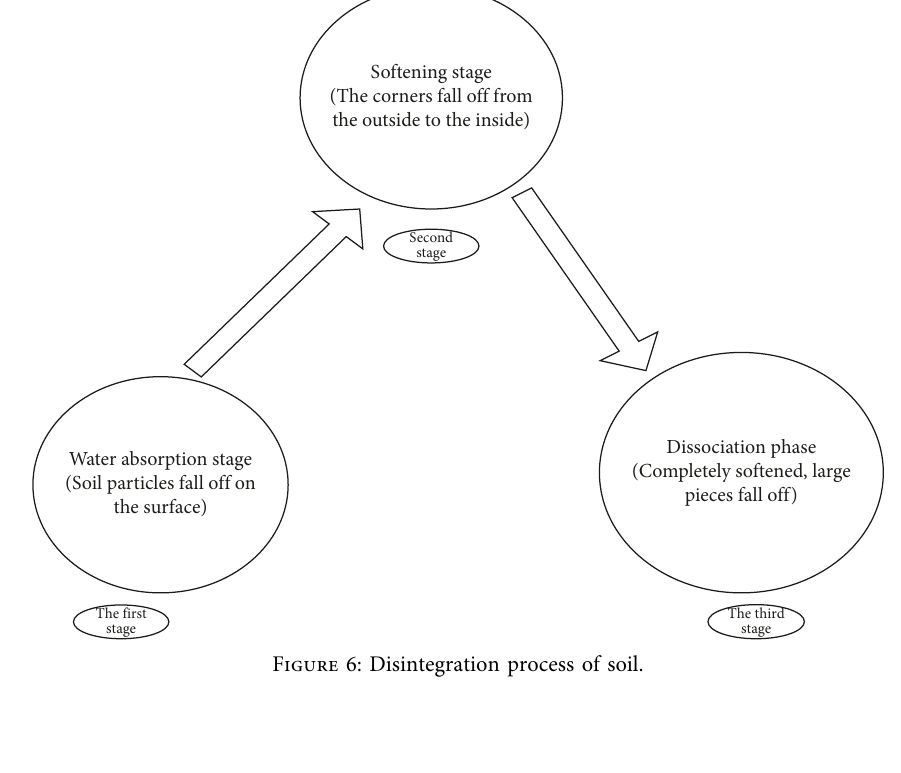
Table 4: Test results of sample disintegration.